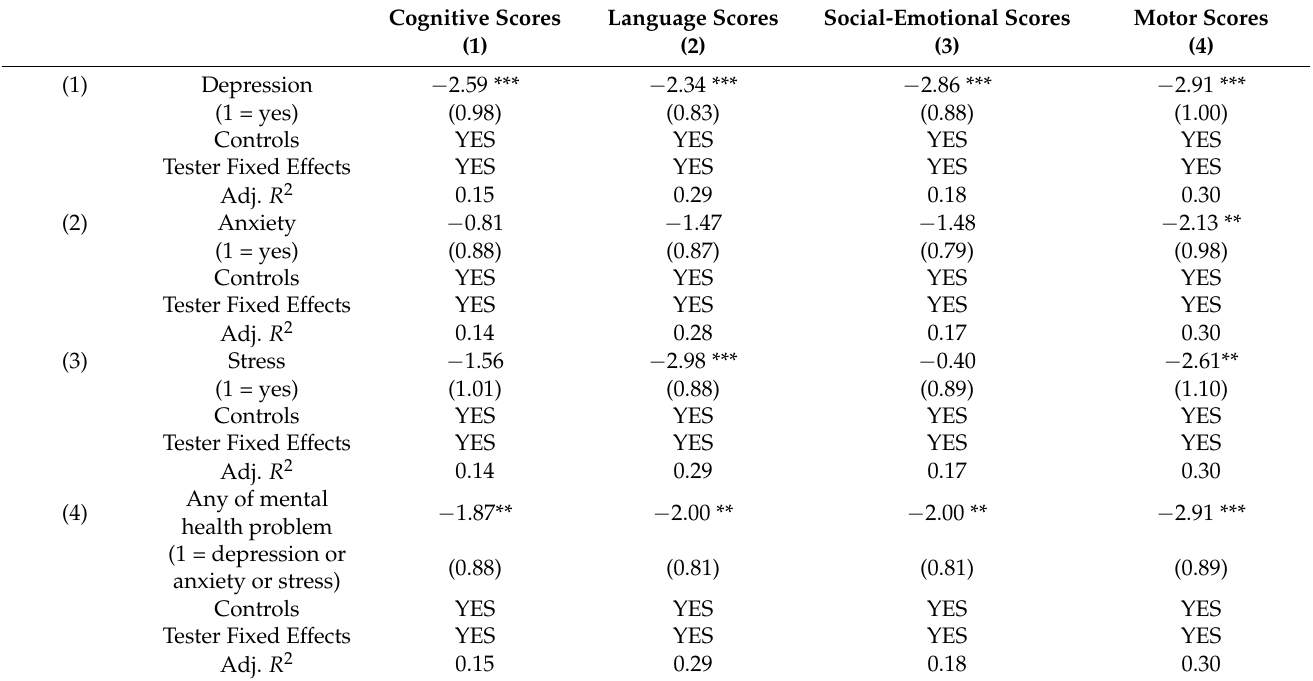
Table 6. Correlates between caregiver’s mental health and child development outcomes using ordinary least squares, n =